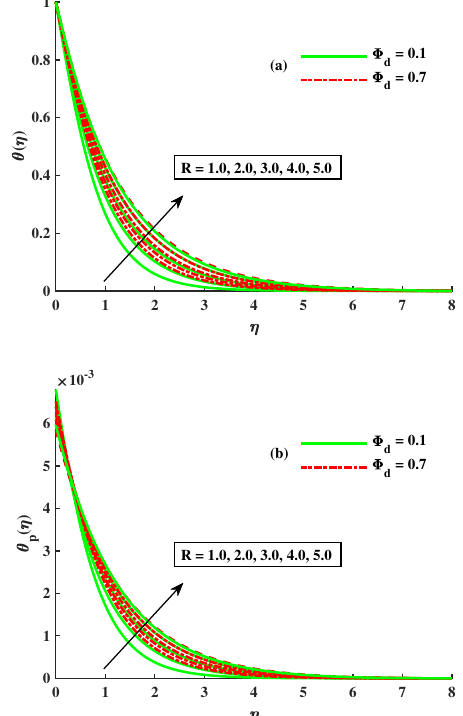
Figure 6. Influence of φ d & M on ( a ) θ ( η ) & ( b ) θ p ( η ) .